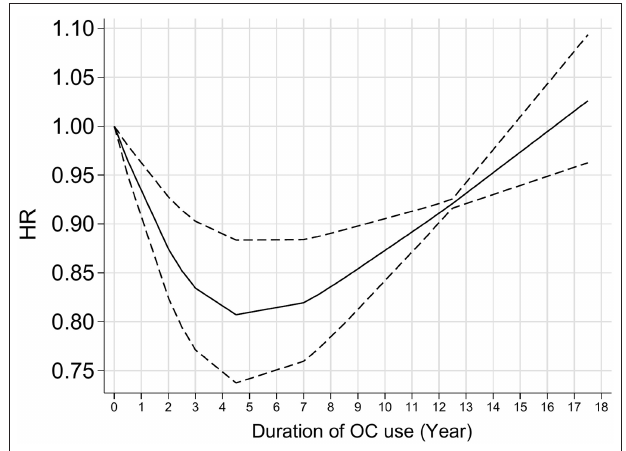
FIGURE 4 | Dose-response relationships between OC use and glioma risk. OC, oral